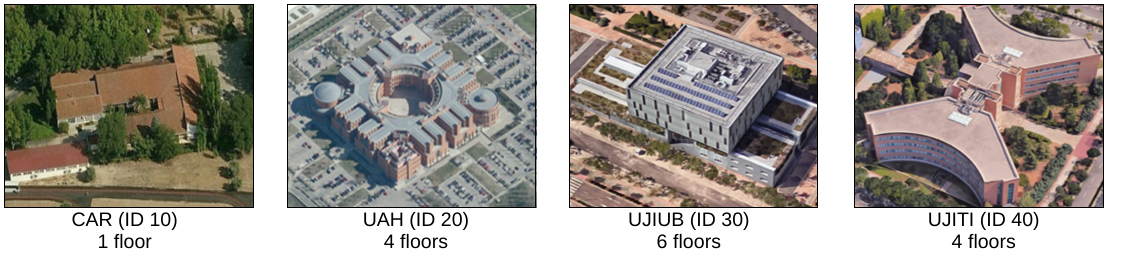
Figure 1. Satellite view of the four buildings used in the Indoor Positioning and Indoor Navigation (IPIN) 2016 competition. The building identifiers are also included in the figure (see Section